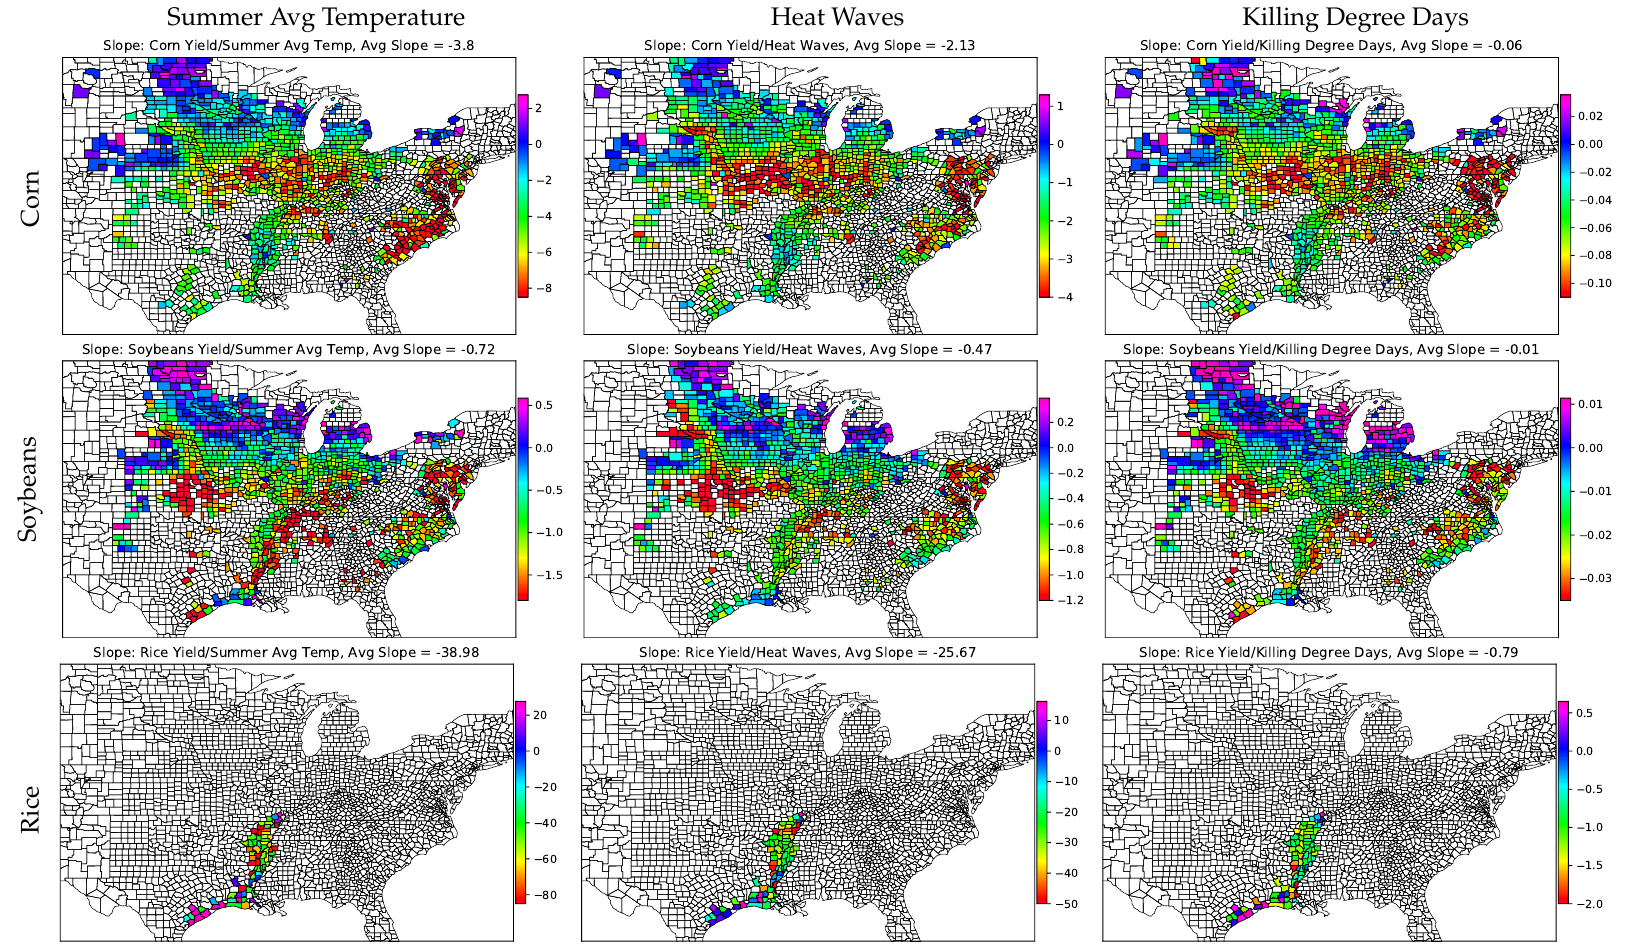
Figure 5. The slopes of the linear regressions between corn (top), soybean (middle), and rice (bottom) yields and summer average temperature (left), heat waves (center), and killing degree days (right), in each US county with reported crop